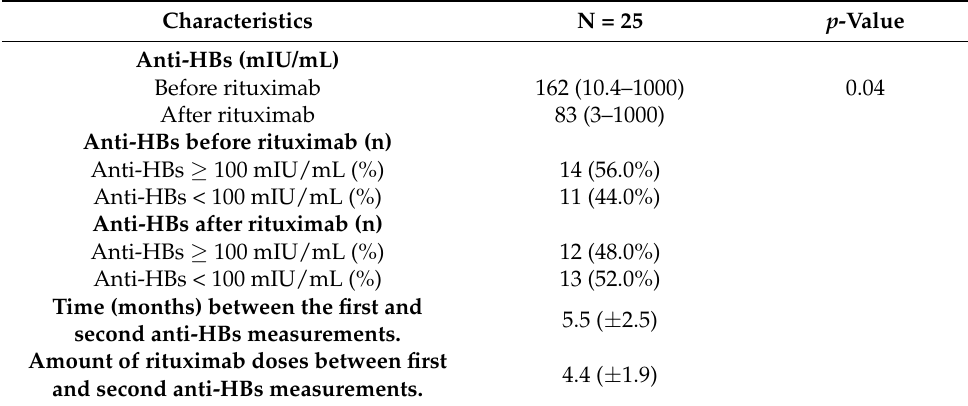
Table 2. Serological profile of participants and rituximab exposure.